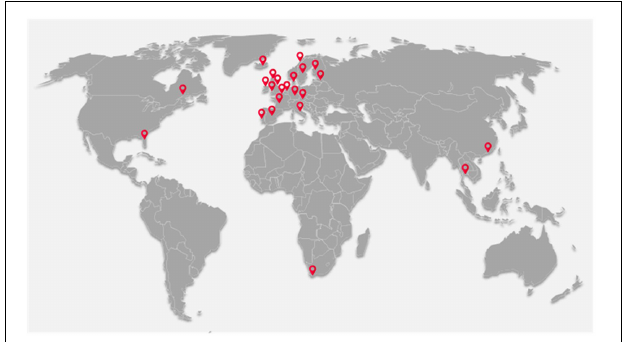
FIGURE 3 | The survey was sent to approximately 500 individuals. The data collected represent 58 organizations, spread across 23 different countries (as indicated by the red points) and four different